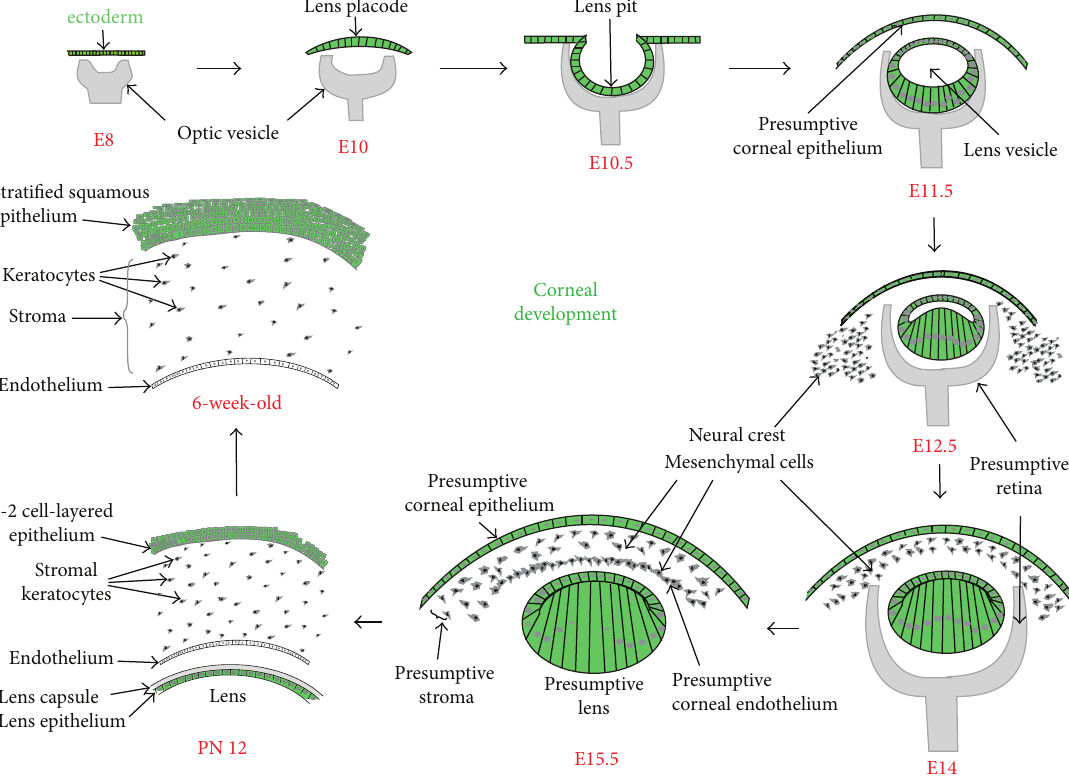
Figure 2: Mouse corneal development. Major events in mouse corneal development between embryonic day 8 (E8) and postnatal day 56 (PN56) are shown. Corneal epithelium and lens are derived from the head surface ectoderm (shown in green), while the corneal stroma and endothelium originate from the neural crest-derived mesenchymal